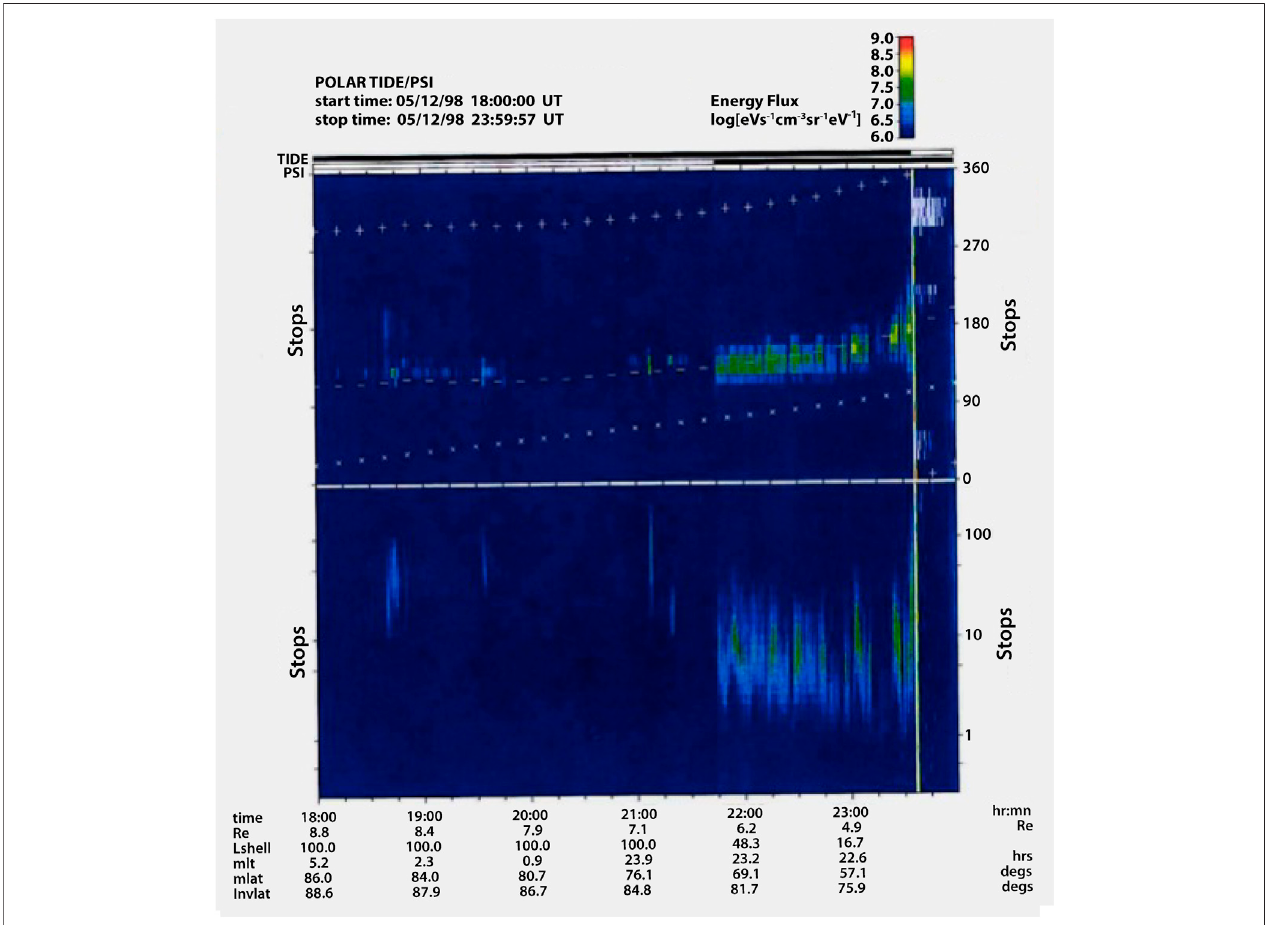
FIGURE6| Asegmentofdataon thepolarwind measured bytheTIDEinstrument onPolartaken inthelobeofthemagnetotailshowingtheimportanteffectofthe plasma neutralizing device.